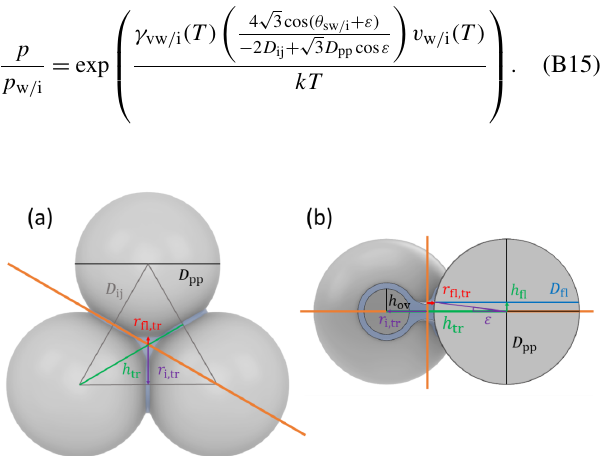
Figure B5. Illustration of filling of a three-membered ring pore in (a) top view and (b) side view. The orange line in panel (a) indicates the cross section shown in panel (b) . The pore filling is illustrated for a liquid water filling level to h fr = 1 . 25nm, but the same geom- etry also applies for filling the pore with ice.